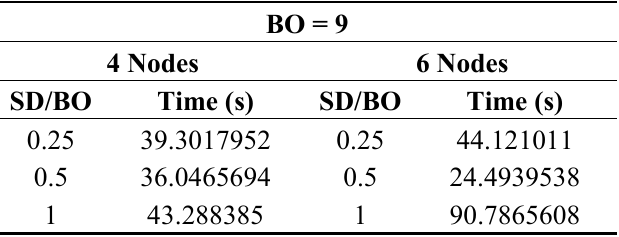
Table 5. Average set-up time. BO = 9.